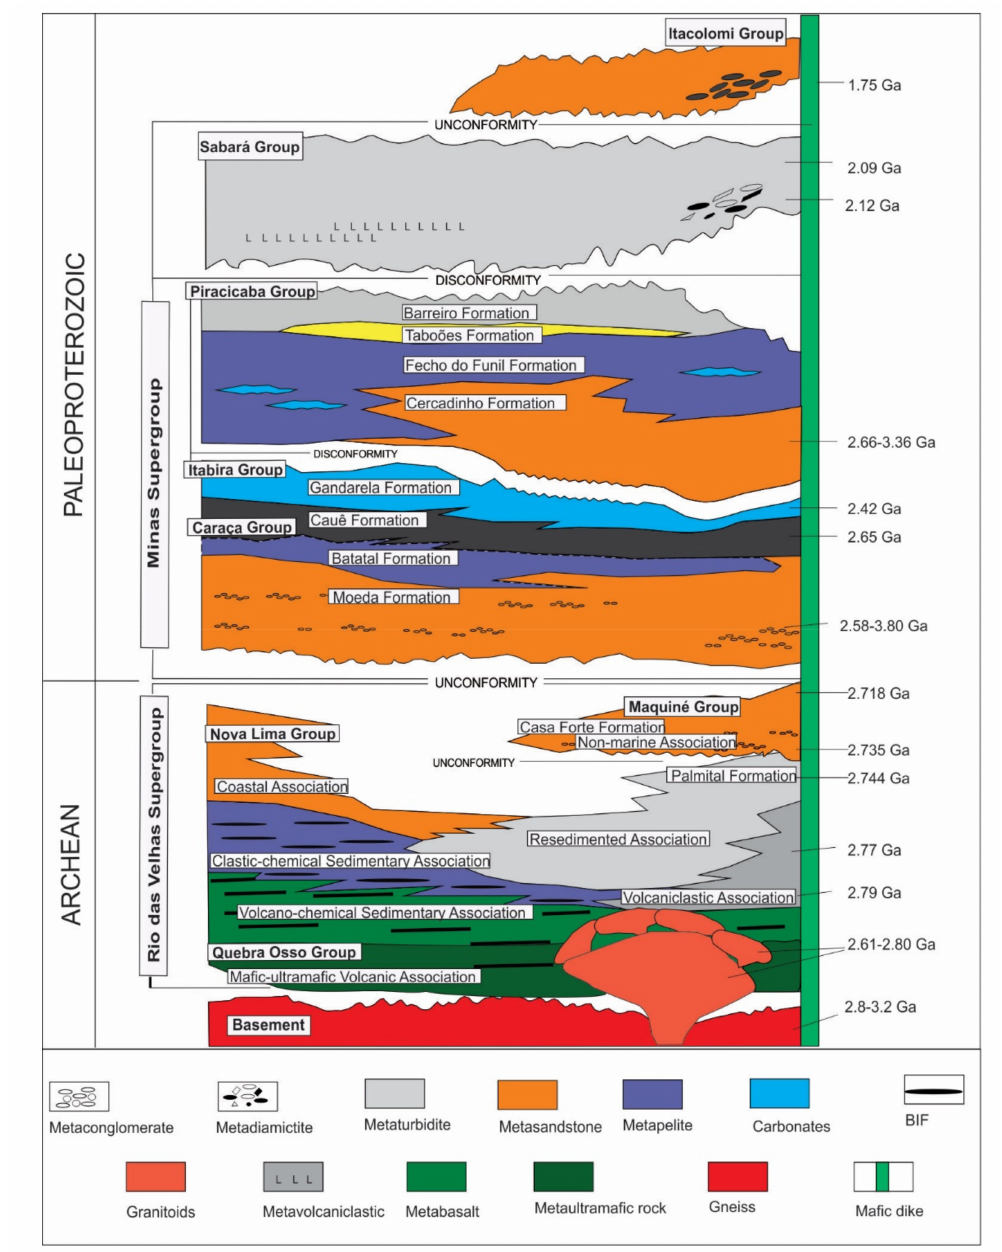
Figure 3. Stratigraphic column of the supracrustal sequences in the Quadril á tero Ferr í fero region (based on